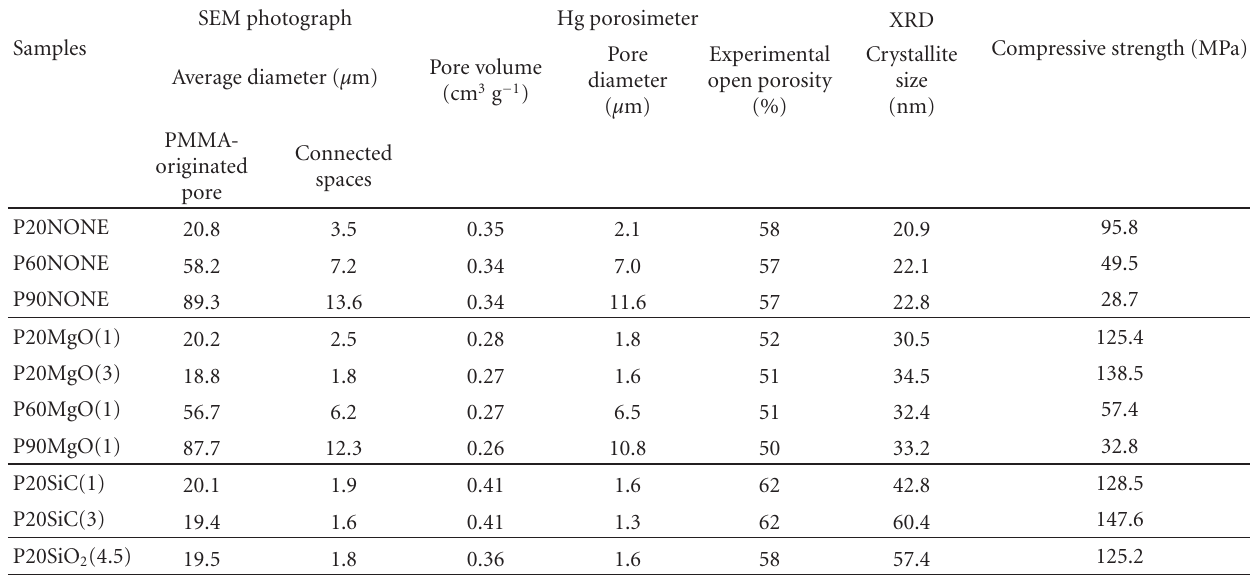
Table 2: Microstructural and mechanical properties of porous alumina-based ceramics.